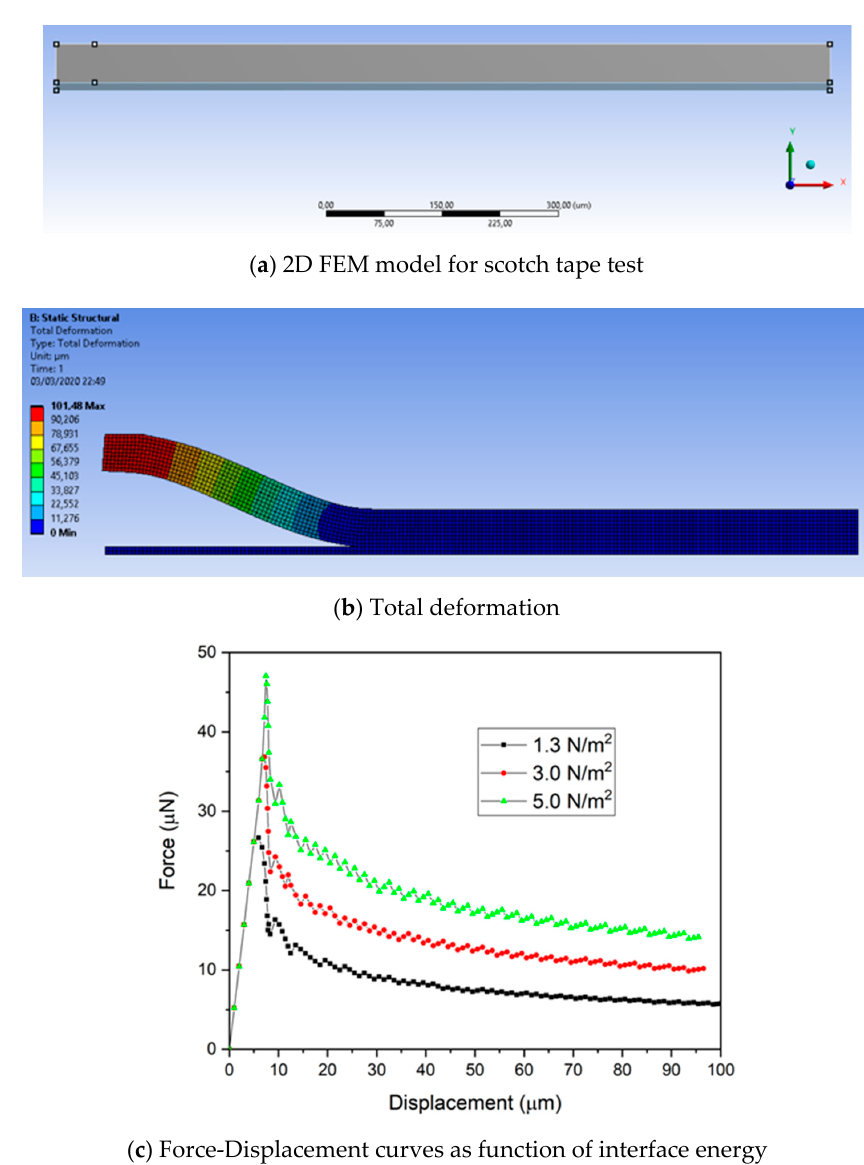
Figure 9. Crack propagation model and simulation results.